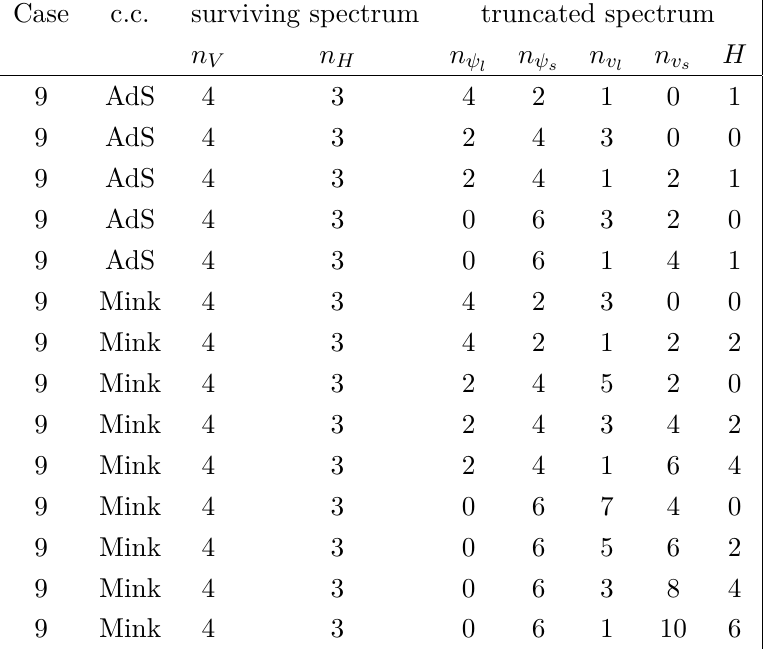
Table 7 . Supersymmetry breaking patterns and truncation of the spectrum — case